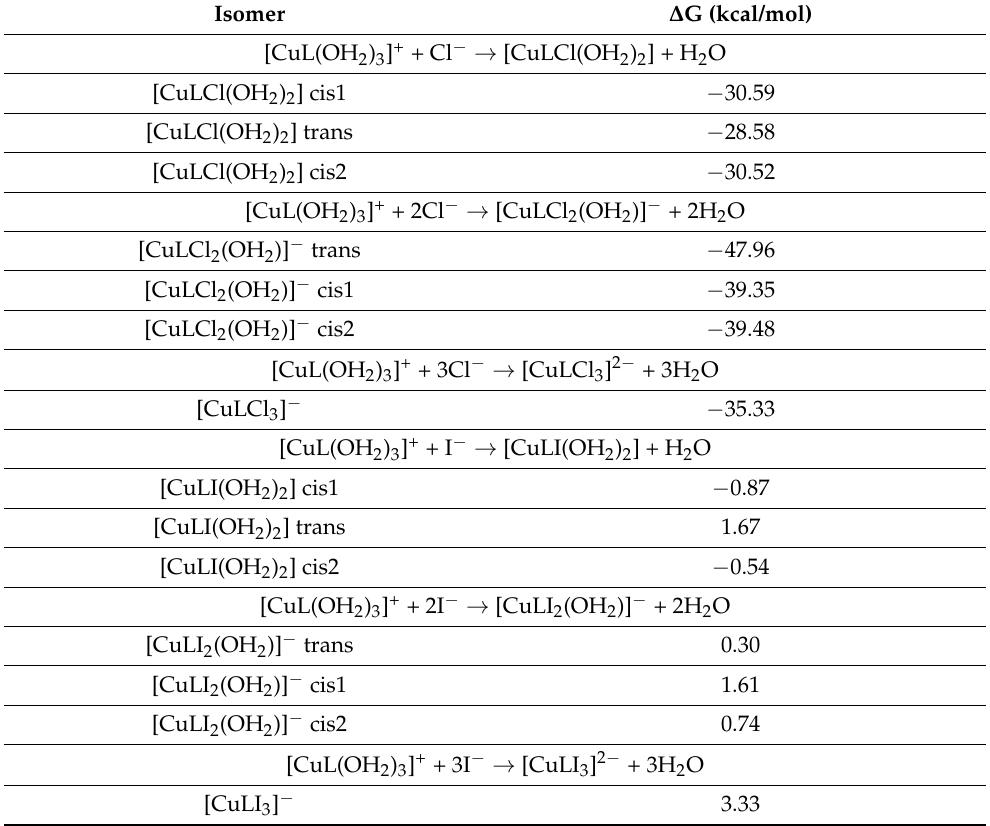
Table 4. Free energy of the reactions for the successive substitution of aqua ligands with iodide or chloride in [CuL(OH 2 ) 3 ] 2+